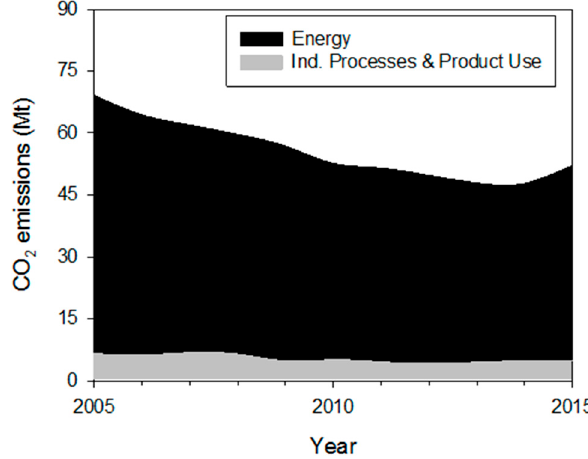
Figure 9. CO 2 emissions’ evolution resulting from energy production and industrial processes and product use in Portugal for the period of 2005–2015 (adapted from [40]).